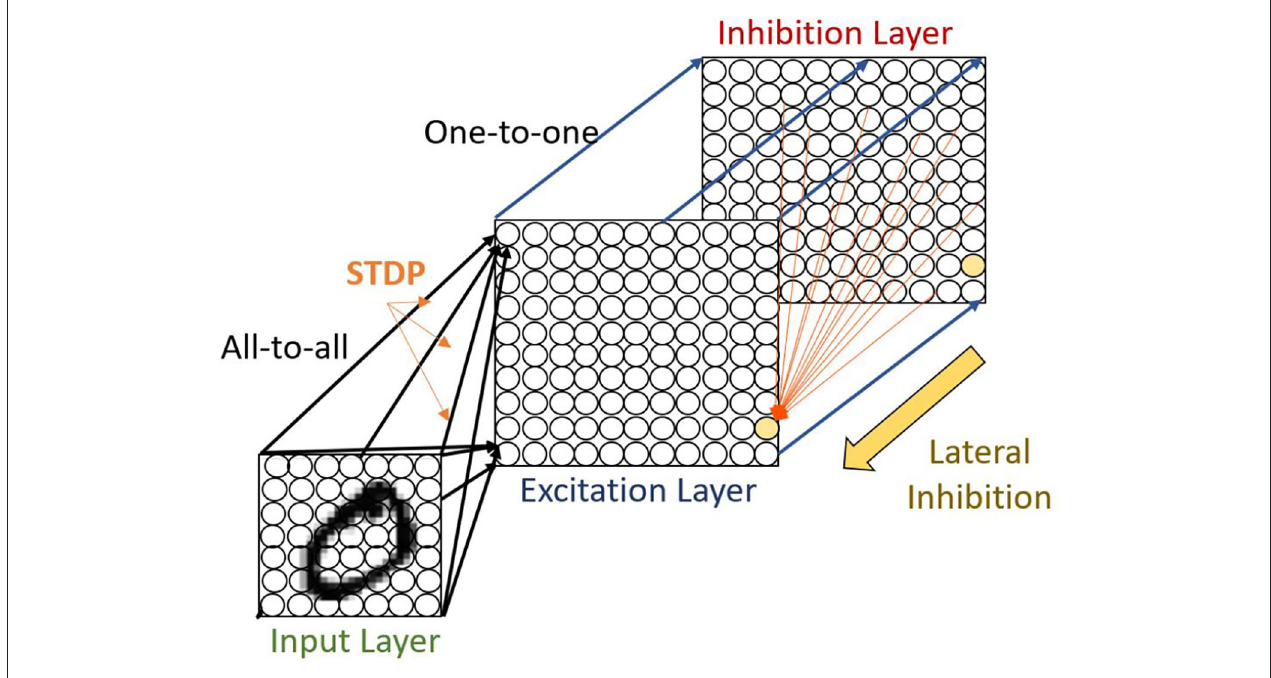
FIGURE 4 | The intensity values of the MNIST image are converted to Poisson-spike trains. The firing rates of the Poisson point process are proportional to the intensity of the corresponding pixel. These spike trains are fed as input in an all-to-all fashion to excitatory neurons. In the figure, the black shaded area from the input to the excitatory layer shows the input connections to one specific excitatory example neuron. The red shaded area denotes all connections from one inhibitory neuron to the excitatory neurons. While the excitatory neurons are connected to inhibitory neurons via one-to-one connection, each of the inhibitory neurons is connected to all excitatory ones, except for the one it receives a connection